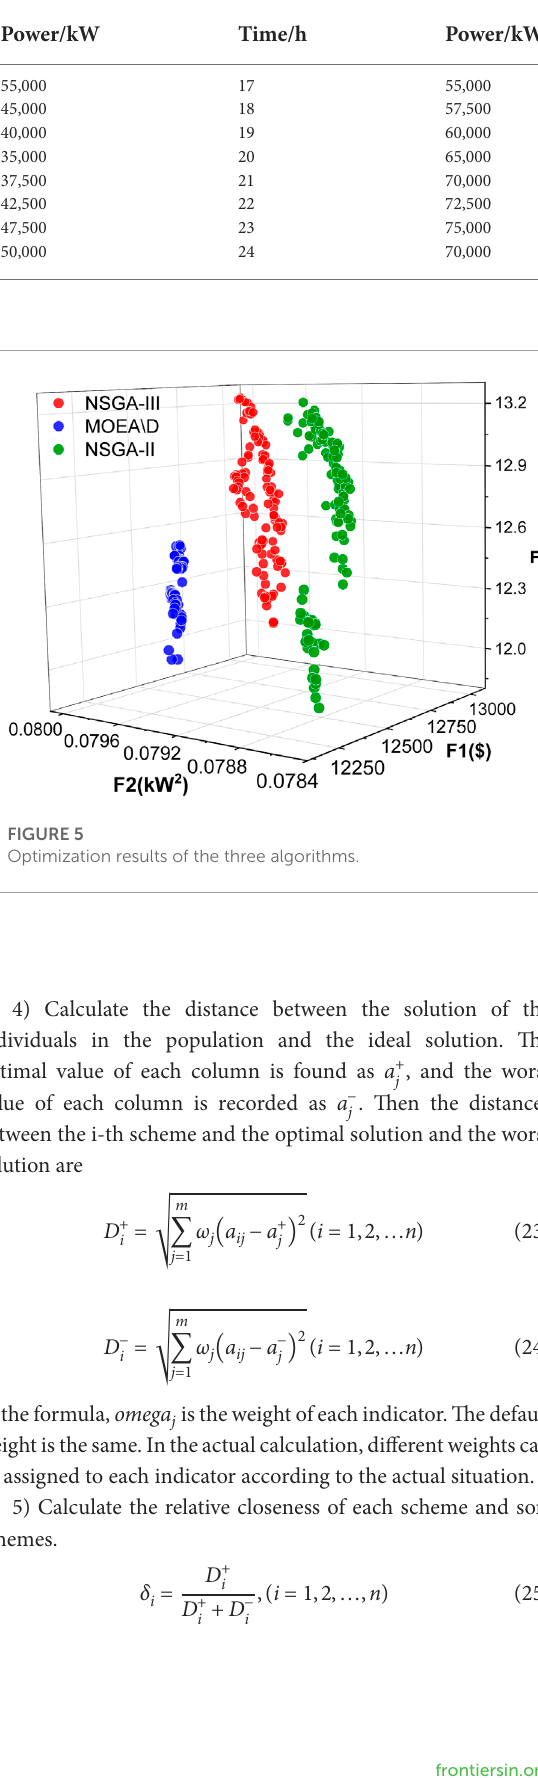
TABLE 2 Dailyloaddemandforthemicrogrid.